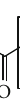
Figure 6: Structural formula of polyethylene glycol diacrylate (PEGDA). Here, n is a degree of